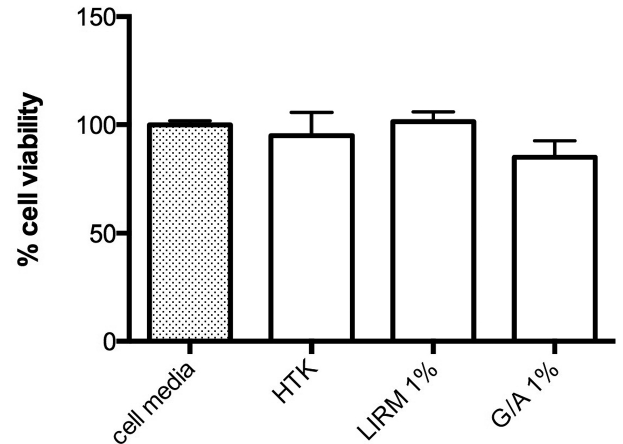
Fig. 3 - Cell viability of L929 cells after incubation with cardioplegic solution for 24 hours. None of the solutions showed cytotoxicity during the observation